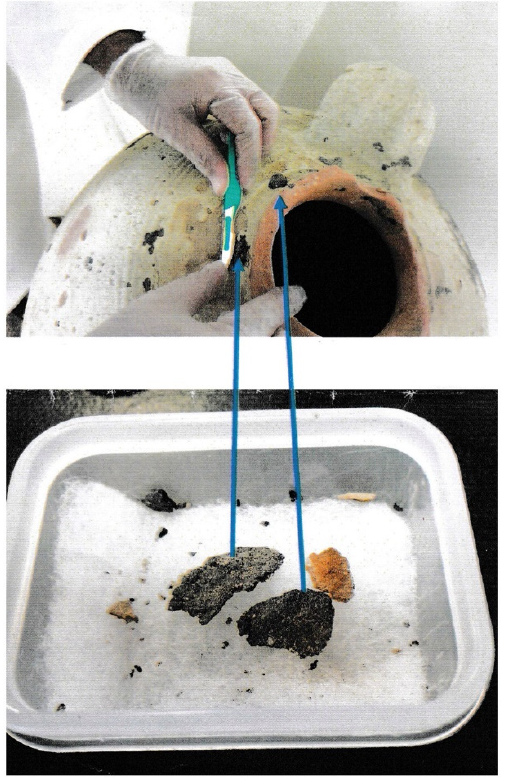
Figure 4. Sampling bitumen from the Muhut amphora (© Ministry of Heritage and Tourism, Sultanate of Oman.